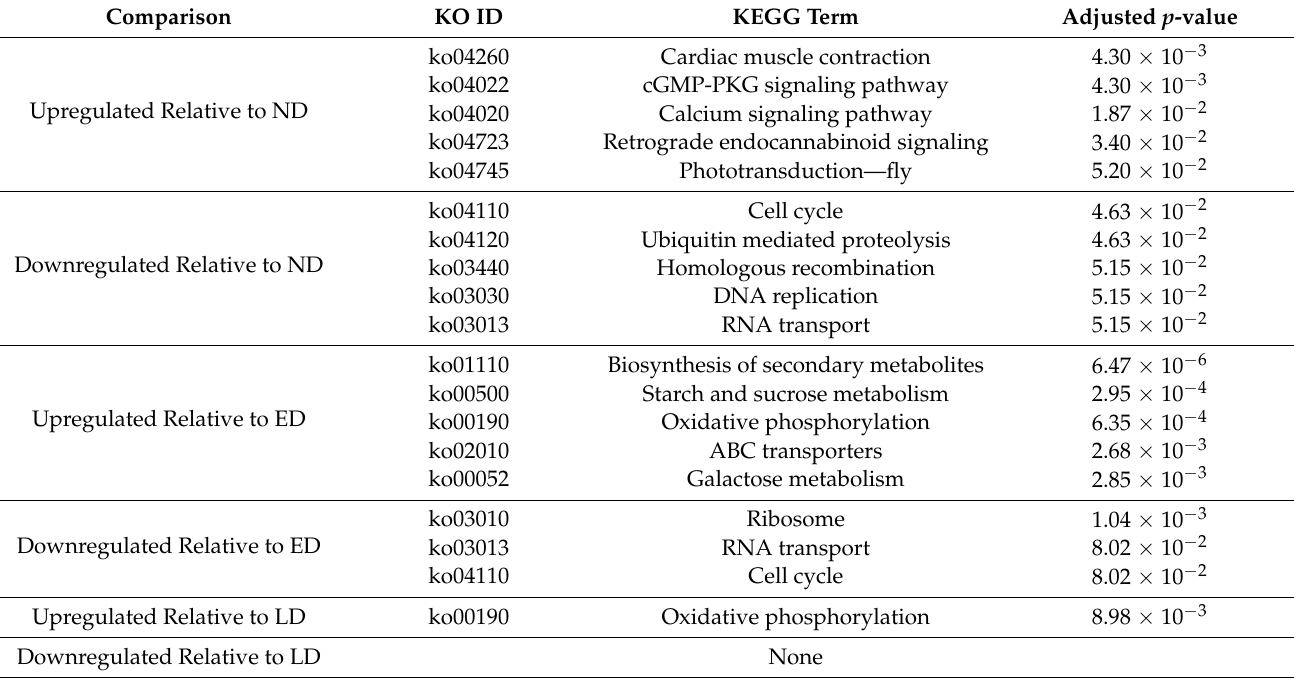
Table 5. Summary of the top five (when available) KEGG pathways involved in MD. The table shows KEGG pathways that were up- or downregulated relative to ND, ED, and LD. Enriched KEGG pathways were identified with the GAGE and Pathview packages in R. Terms were sorted by the Benjamini-Hochberg adjusted p -value. A complete list of up- and downregulated KEGG terms can be found in Supplementary Table